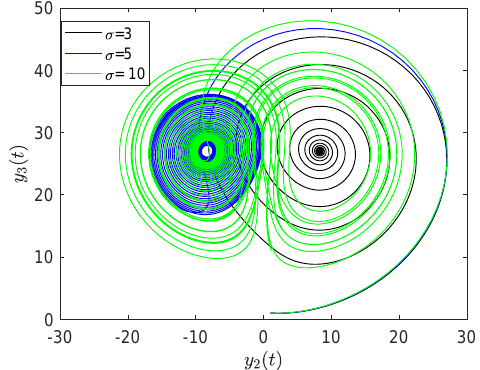
Figure 27. Phase portraits of y 2 and y 3 when varying σ